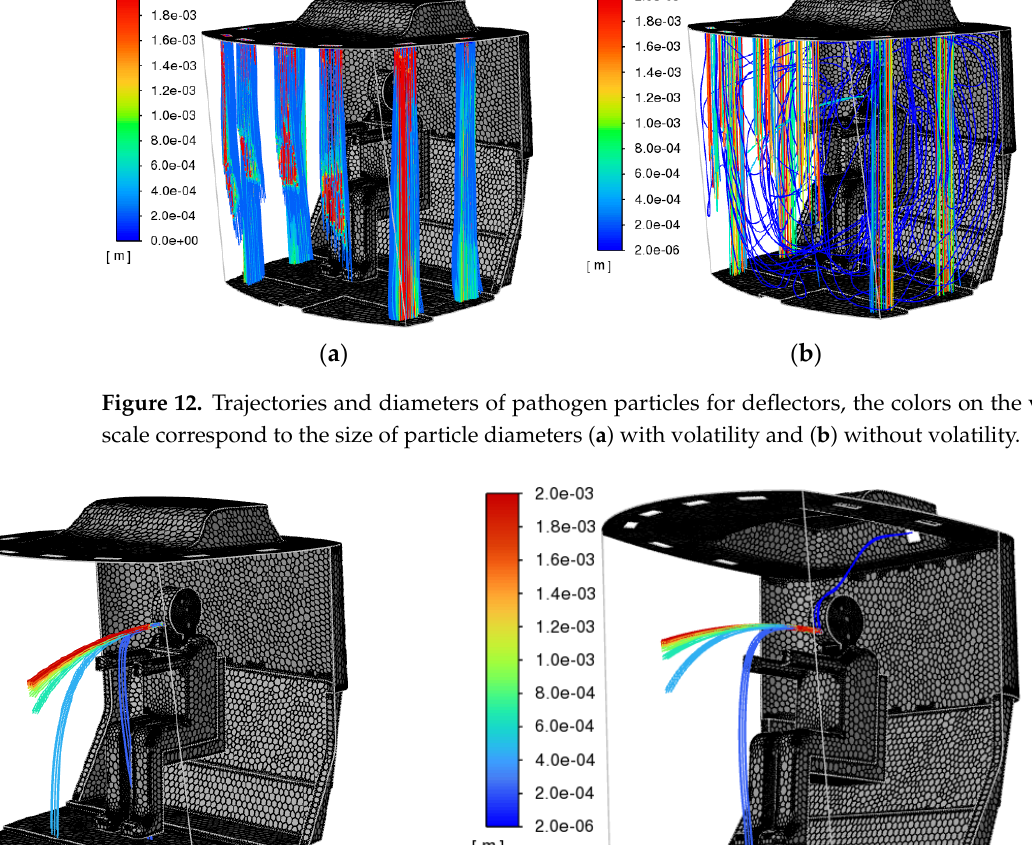
Figure 11. Relative humidity °C.